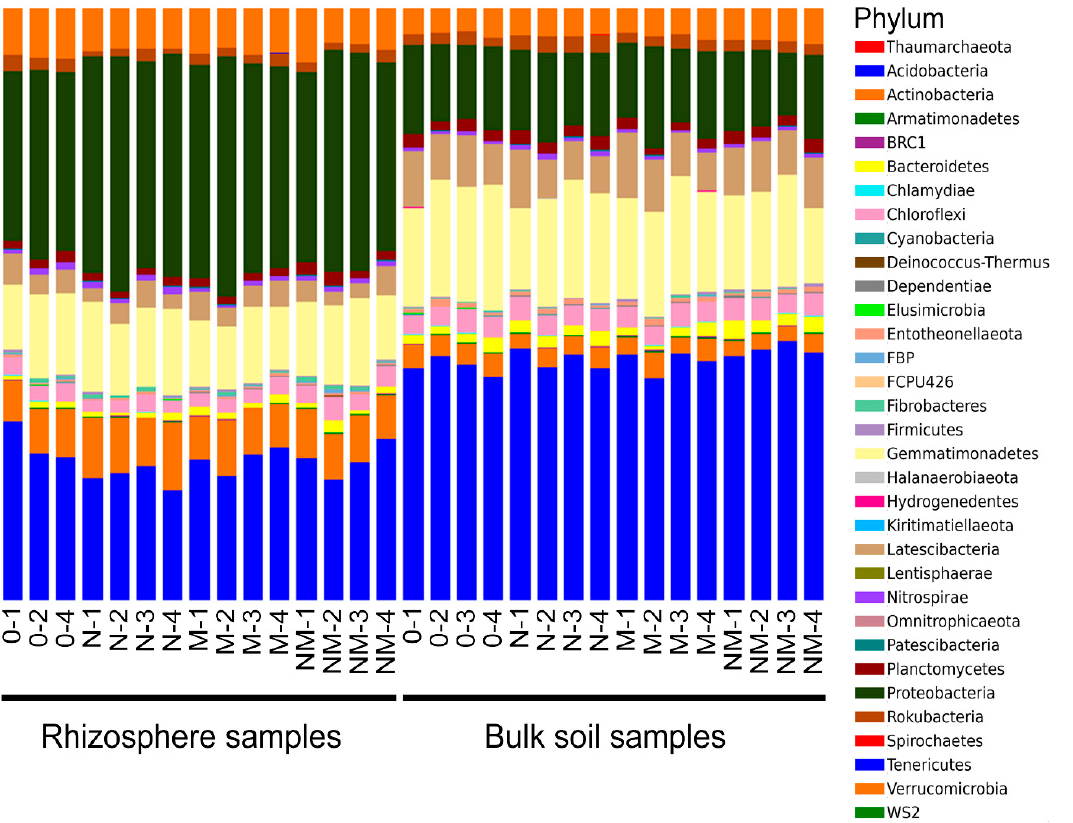
Figure 1. Phylum-level taxonomic composition of the bacterial microbiota in the analyzed rhizospheric and bulk soil habitats, as obtained by metabarcoding of prokaryotic 16S rRNA genes.